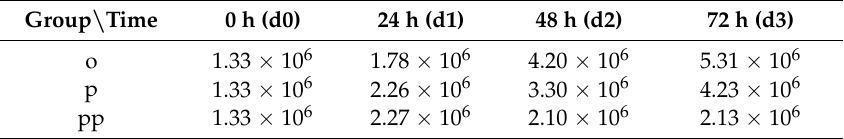
Table A1. Cell number of MCF-7 culture after treatment with DMSO (group o) or XD14 (group p and pp) for 0, 24, 48 and 72 h.